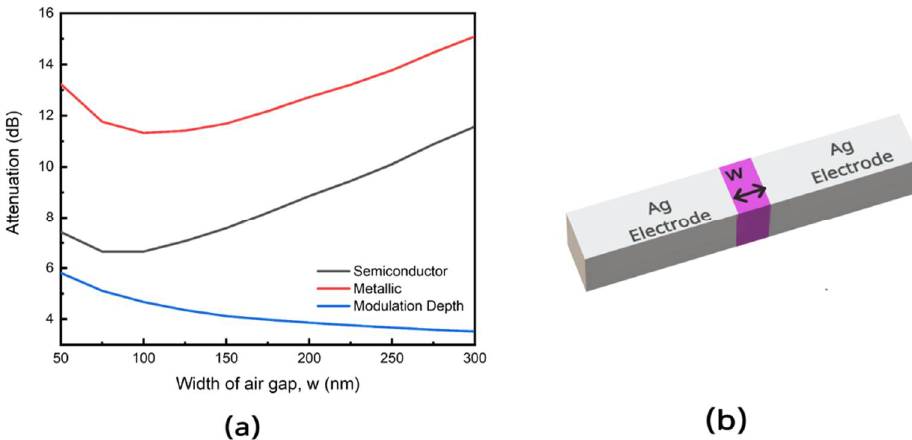
Figure 5. ( a ) Attenuation of light at 1550 nm for the metallic and semiconductor phases of VO 2 with the modulation depth for different widths w of the plasmonic slot. ( b ) Cross section of the plasmonic slot of width (w) with violet colour representing VO 2 and yellow colour representing Ag electrode.